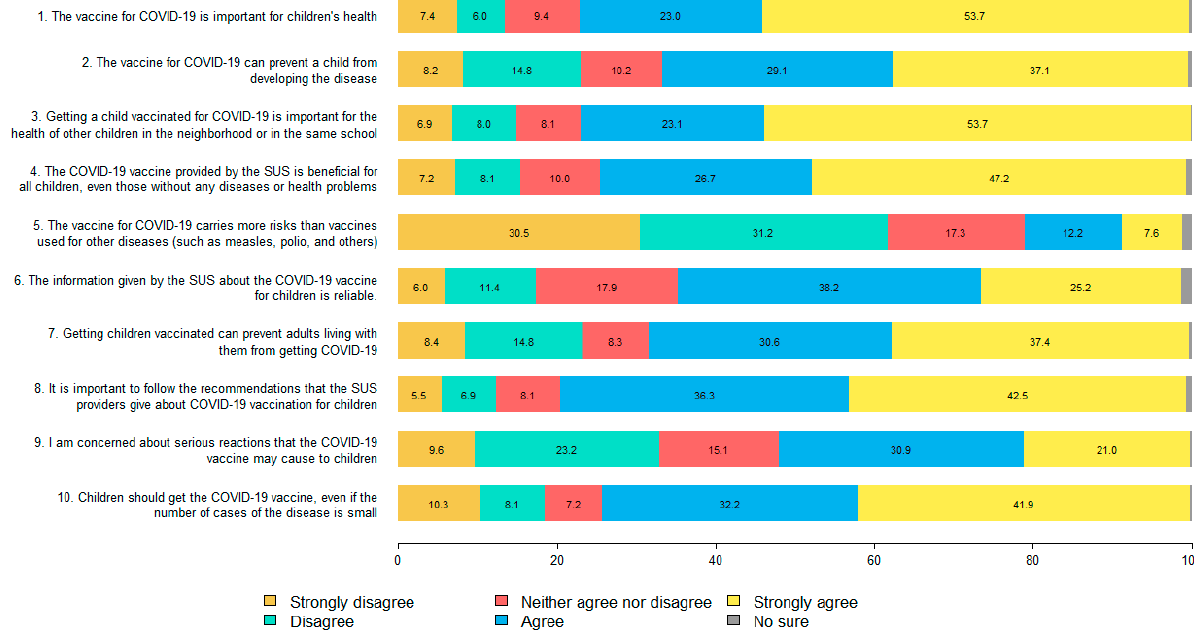
Figure 1. Frequencies of answers to the adapted SAGE-WG questionnaire. The abbreviation SUS in the questions 4, 6, and 8 refers to the Brazilian Unified Health System (in Portuguese, Sistema Único de Saúde ). Table 4. Descriptive statistics for the scores obtained from the adapted SAGE-WG questionnaire, and comparisons between groups. Higher scores suggest higher vaccination hesitance